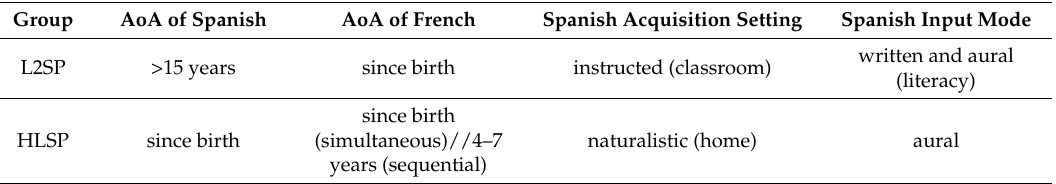
Table 2. Participant information based of Age of Acquisition (AoA) of Spanish and French, acquisition setting, and input